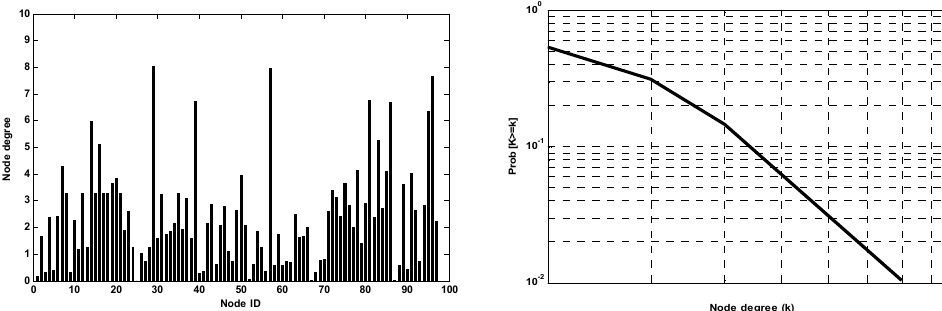
Figure 2. ( left ) the node degree distribution in the Reality mobility scenario, and ( right ) when it is plotted in a log-log scale. The almost linear of the plot of the node degree in the log-log scale verifies that the node degree is power-law distributed.